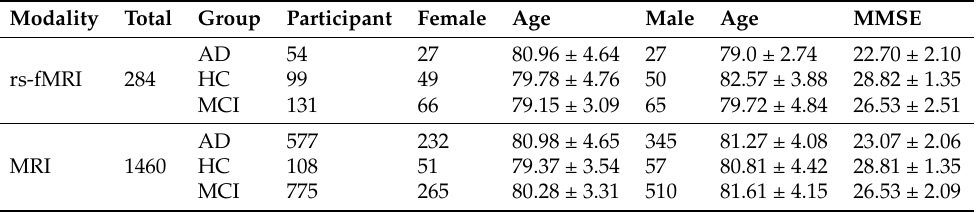
Table 1. The demographic of two sets of ADNI data used in model development shows all the groups are older adults within an age group of >